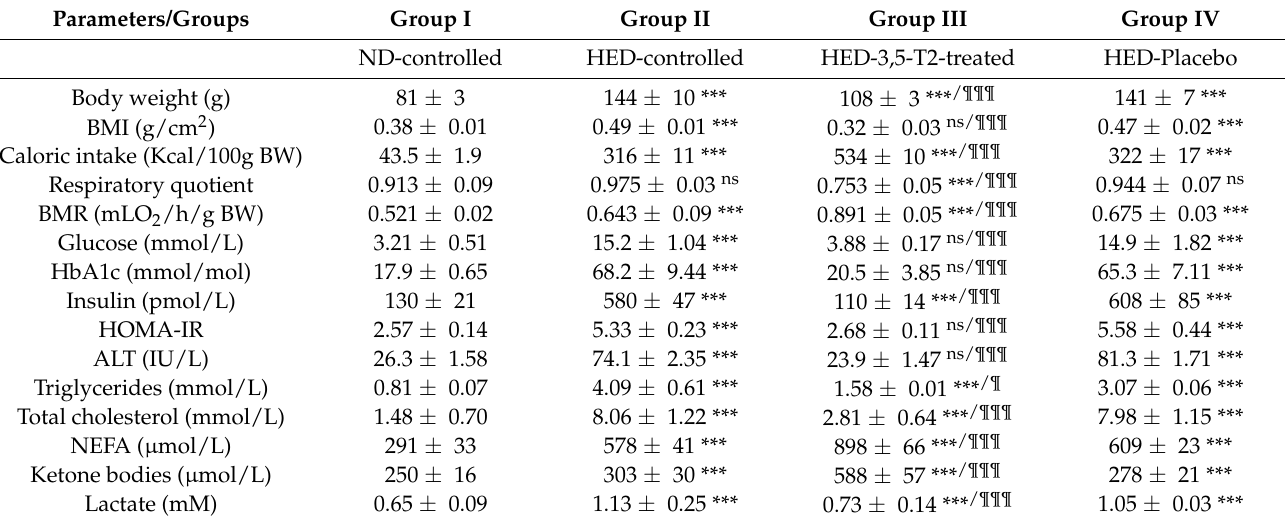
Table 2. In vivo effects of 3,5-T2 on resting energy expenditure and plasma metabolic biomarkers from experimental P. obesus